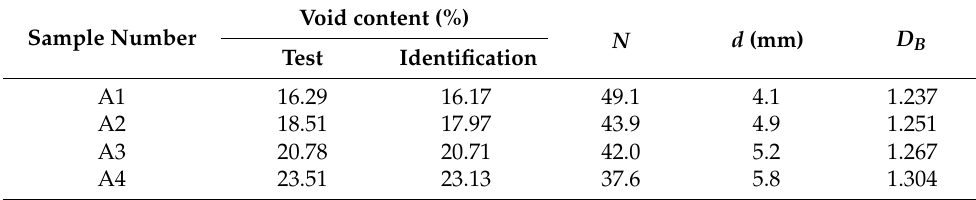
Table 6. Void characteristics of